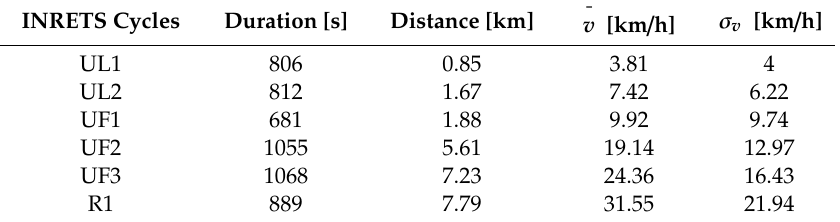
Figure 7. INRETS driving cycles: ( a ) UL1, ( b ) UF1, ( c ) R2 ( d ) A2. Table 1. Characteristics of the UL1, UF1, R2 and A2 INRETS driving